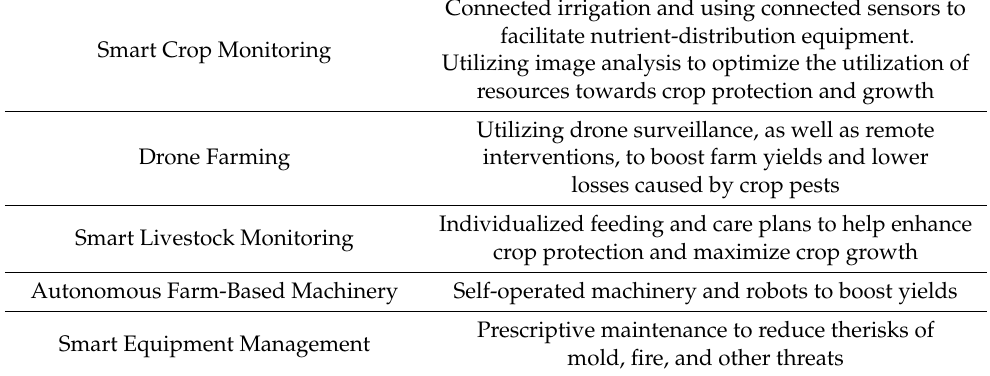
Table 1. Crop-Protection advancements in agriculture. Connected irrigation and using connected sensors to facilitate nutrient-distribution equipment. Smart Crop Monitoring Utilizing image analysis to optimize the utilization of resources towards crop protection and growth Utilizing drone surveillance, as well as remote Drone Farming interventions, to boost farm yields and lower losses caused by crop pests Individualized feeding and care plans to help enhance Smart Livestock Monitoring crop protection and maximize crop growth Autonomous Farm-Based Machinery Self-operated machinery and robots to boost yields Prescriptive maintenance to reduce therisks of Smart Equipment Management mold, fire, and other